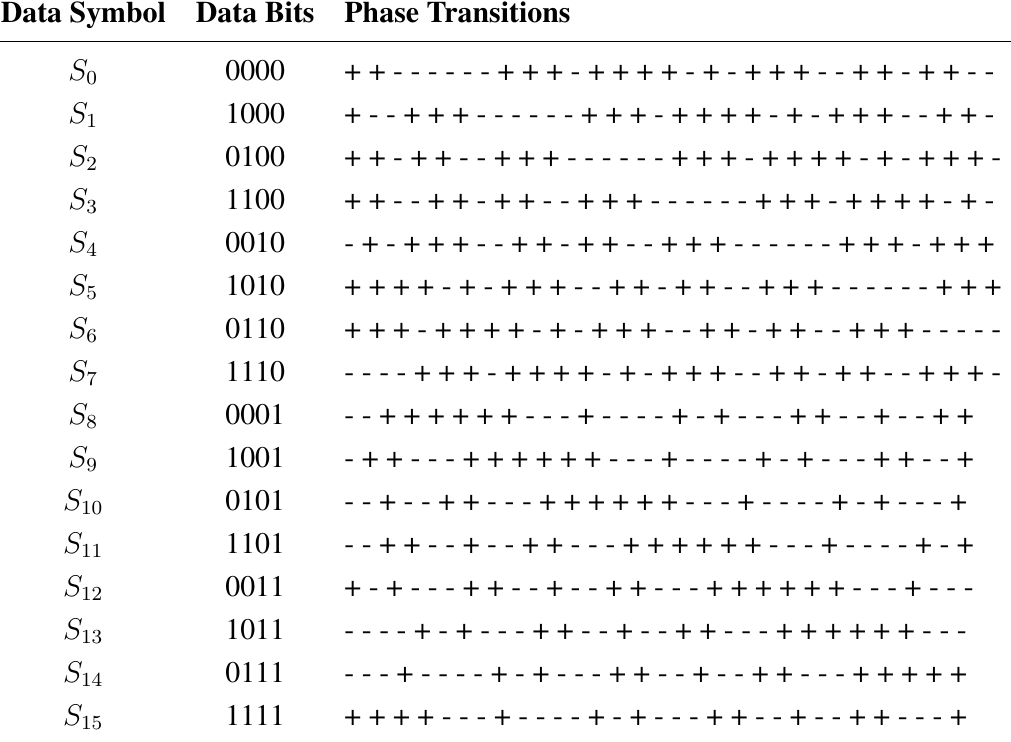
Table 4. Phase transitions of chip sequences in 2450-MHz PHY of IEEE